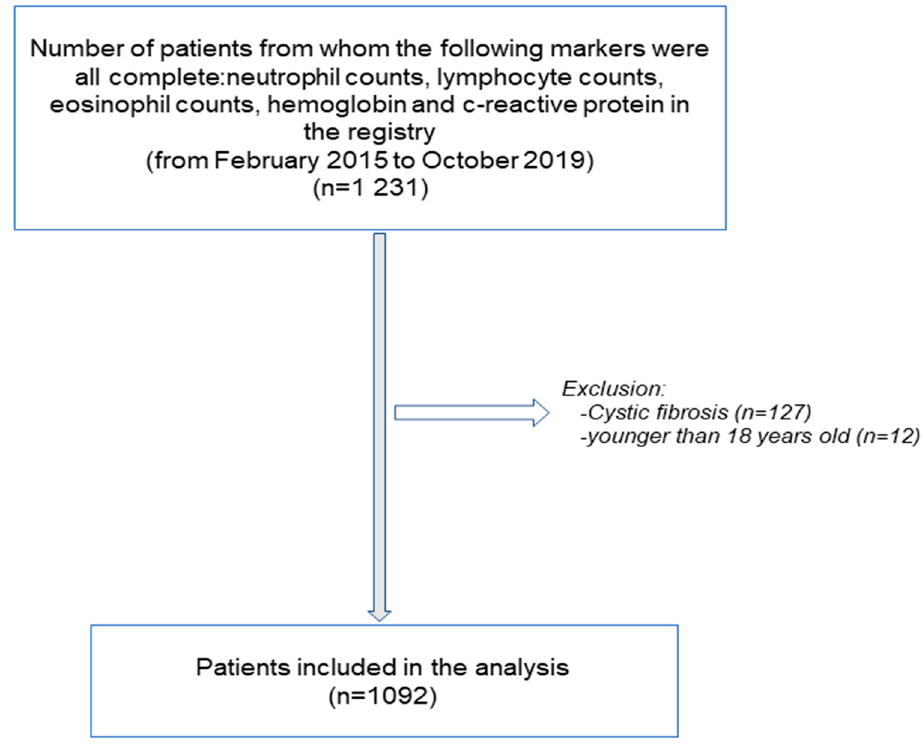
Figure 1. Flow-chart of the study.